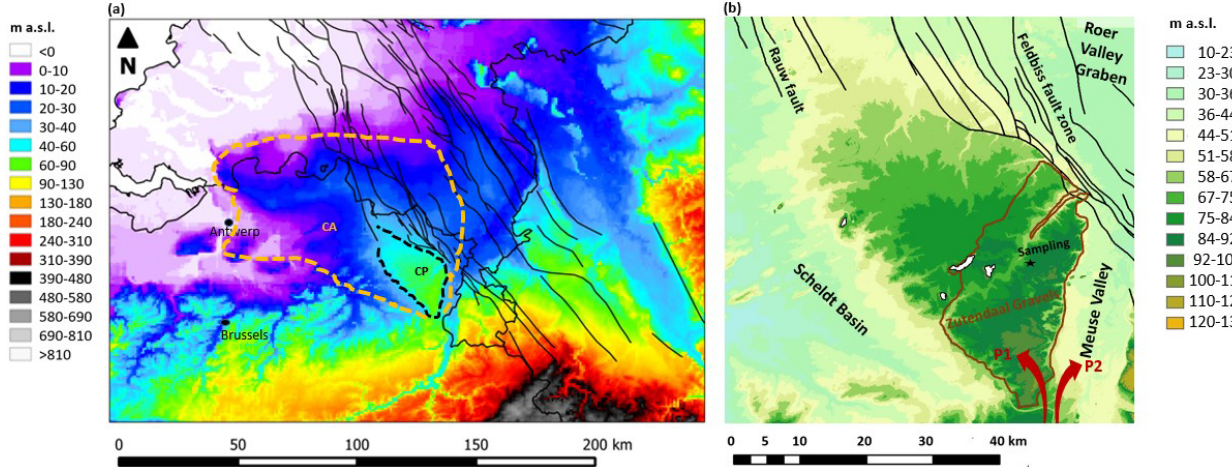
Figure 3. (a) Location of the Campine Plateau (black dashed line) in the low-lying region of the Campine area (CA, delineated by an orange dashed line) on a DTM (digital terrain model; U.S. Geological Survey’s EROS Data Center: GTOPO30, 1996), with indications of main faults (Deckers et al., 2014). The whole area belongs to the sandy lowlands of the European Sand Belt. The Campine Plateau stands out of its environment by > 50m. (b) The Zutendaal gravels (delineated with a brown line) cover the southeastern region and the most elevated parts of the plateau (DTM from GDI-Vlaanderen, 2014). They were deposited by the Meuse River by the time it was flowing westward (red arrow, P1). Later on, this course was abandoned as the Meuse River moved eastward to form the present-day Meuse Valley (red arrow,